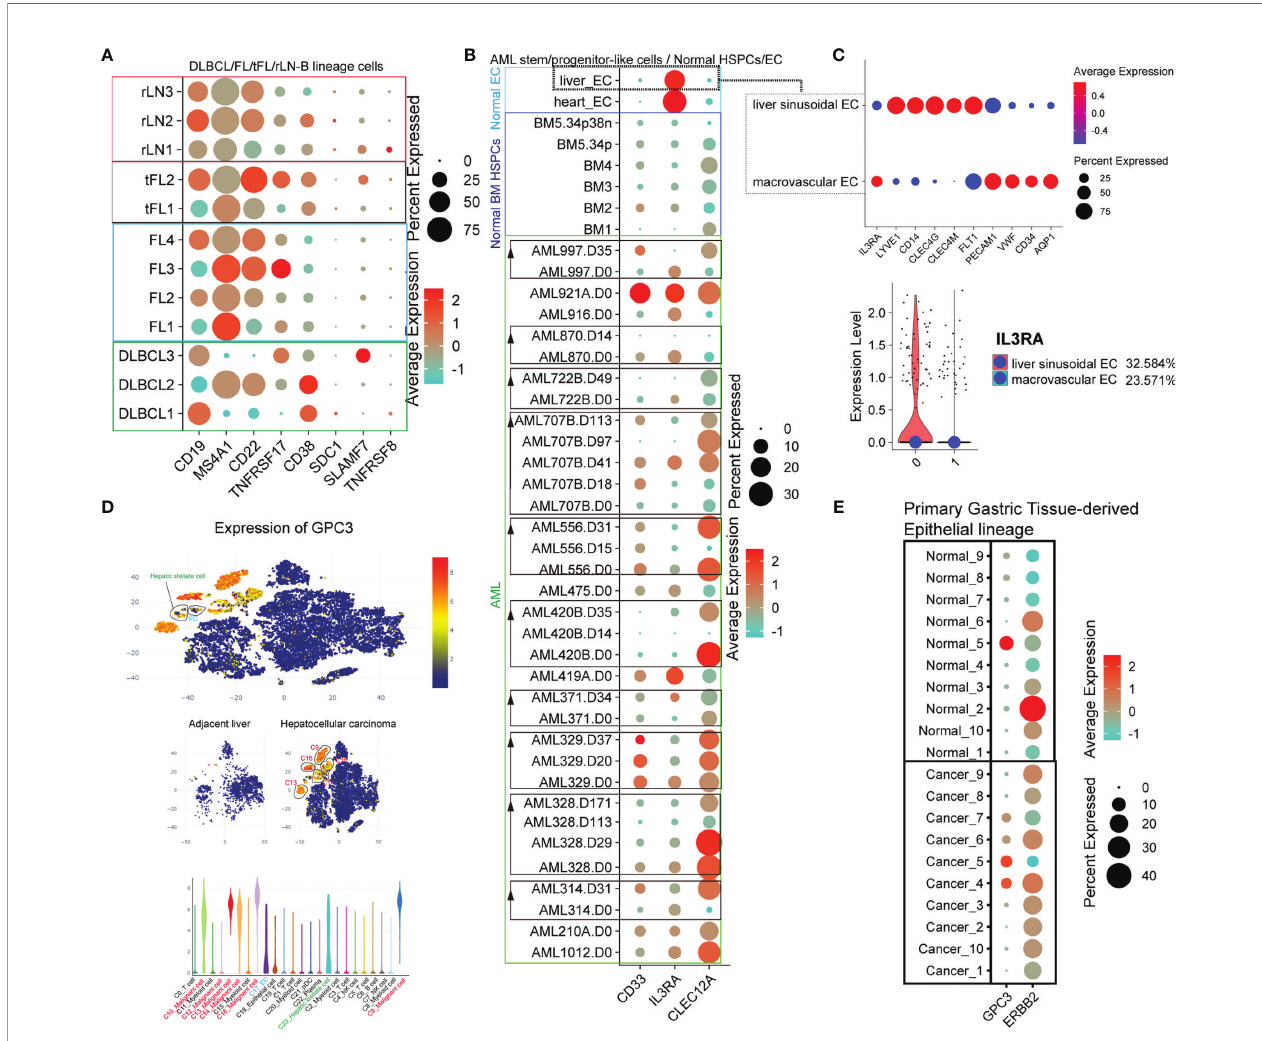
FIGURE 5 | The difference of expression patterns of solid tumor antigens (GPC3, B4GALNT1, and ERBB2) in malignant cells and nonmalignant cells. (A) Dot plot shows the expression level of target antigens (CD19, MS4A1, CD22, TNFRSF17, CD38, SDC1, SLAMF7, and TNFRSF8) in B lineage-related cells derived from lymphomas (DLBCL, FL, and tFL) and rLN. (B) Dot plot shows the expression level of target antigens (CD33, IL3RA, and CLEC12A) in hematopoietic stem/ progenitor-like cells obtained from BM samples of AML patients and healthy donors, and in normal liver/heart EC clusters. “ AML314.D31 ” represents the sample of patient AML314 after 31 days of treatment. BM5.34p means the sample of BM CD34-positive cells derived from healthy donor BM5, and BM5.34p38n means the sample of BM CD34-positive and CD38-negative cells derived from healthy donor BM5. (C) The expression level of IL3RA in liver sinusoidal endothelial cells and macrovascular endothelial cells. (D) GPC3 expression levels in adjacent liver and hepatocellular carcinoma at scRNA-seq level. (E) GPC3 and ERBB2 expression levels of the epithelial lineages in normal primary gastric tissues and gastric